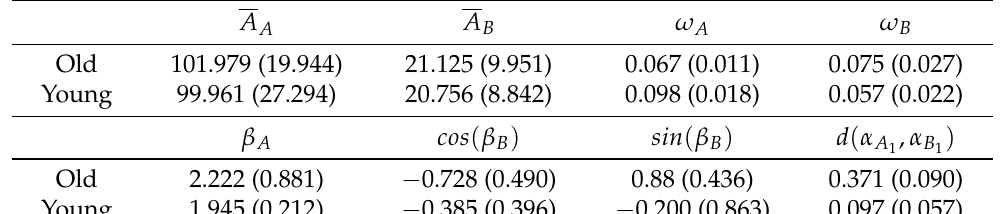
Table 2. Mean (SD) for a selection of FMM parameters for old and young subjects.